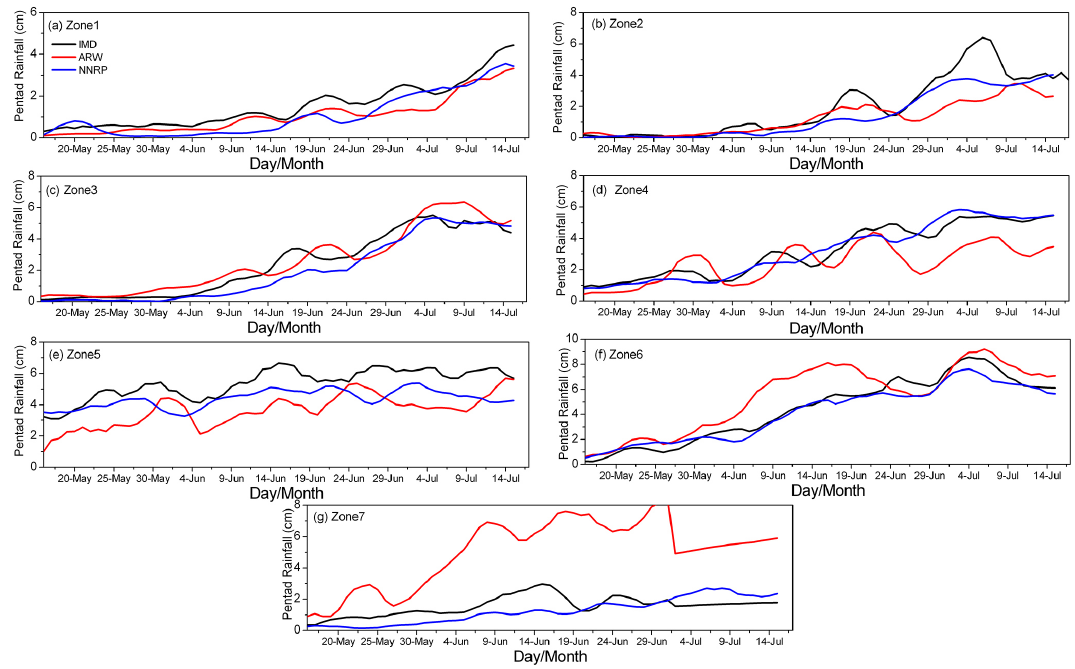
Figure 2. Time series of running pentad rainfall (cm) averaged over different rainfall zones in the period 12 May–30 June for the 10-year (2000–2009) composite, along with corresponding pentad rainfall derived from NNRP reanalysis and IMD 50km gridded rainfall data. The first pentad is 12–16 May, the second pentad is 13–17 May...and the last pentad is 26–30 June. Panels (a) to (g) correspond to zone 1 to zone 7.